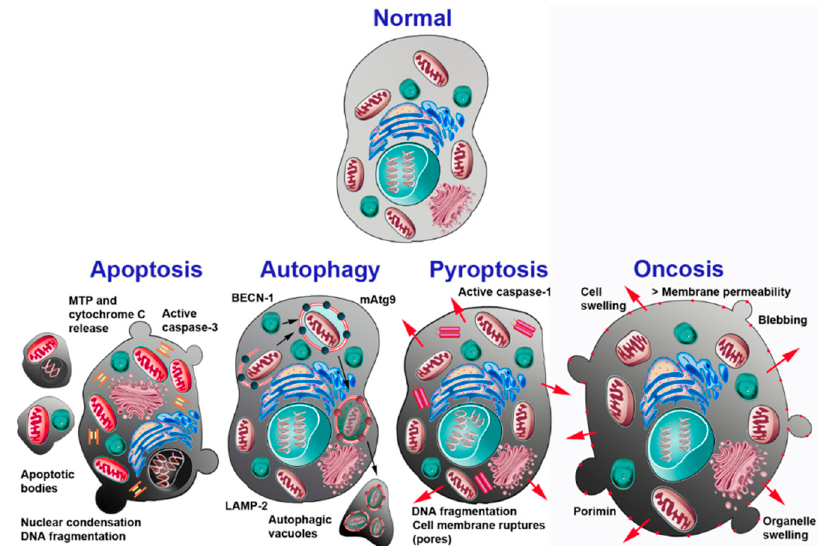
Figure 1. Schematic drawing of the main different types of cell death occurring in neurons. The main cellular and molecular events associated with each death process are indicated. Abbreviations: BECN-1 = beclin-1; LAMP-2 = lysosome-associated membrane protein 2; mAtg9 = mammalian autophagy-related protein 9; MTP = mitochondrial transition pore. Reprinted with permission from [2].